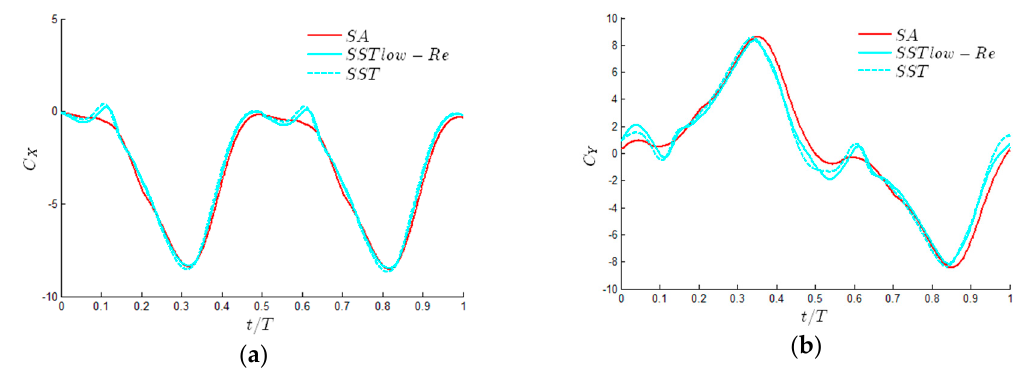
Figure A1. Evolution of ( a ) thrust coe ffi cient and ( b ) lift coe ffi cient for y 0 = 0.4, θ 0 = 50 ◦ , and f ∗ = 0.21 as predicted by the different turbulence model.